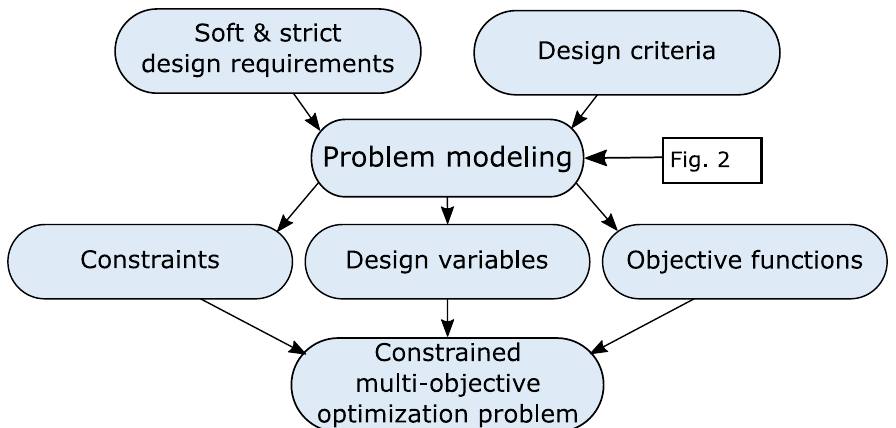
Figure 3. A scheme of aspects for a multi-criteria design